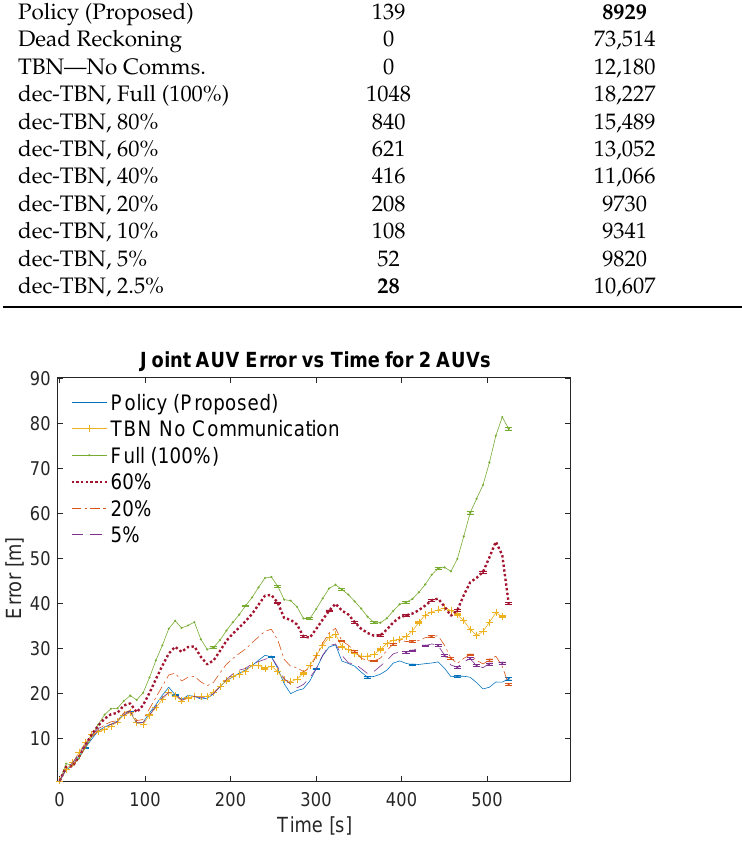
Figure 7. Overview of simulation results for 2 AUVs using varying communication bandwidths. Error bars show standard error of the